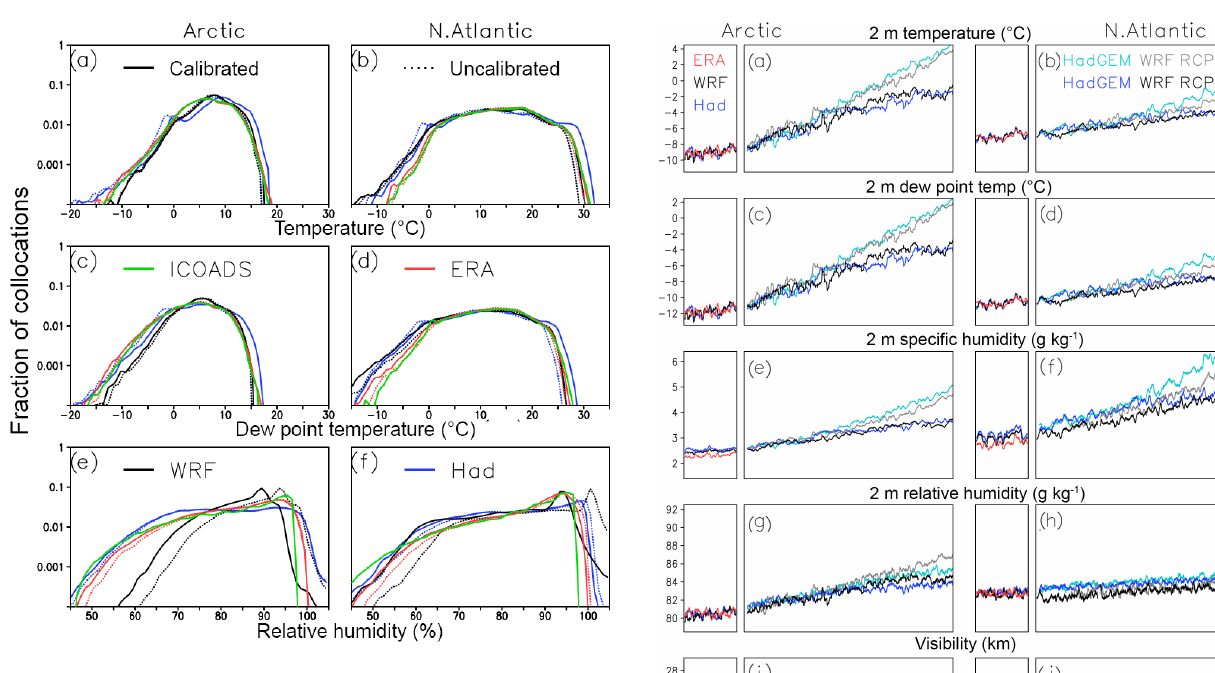
Figure 3. Distribution shifts under a homogeneous two-step cal- ibration. Shown are the fraction of 59966 Arctic (left panels) and 94703 North Atlantic (right panels) collocations of Fig. 1, as a func- tion of calibrated (solid lines) and uncalibrated (dashed lines) (a, b) air temperature, (c, d) dew point temperature, and (e, f) relative humidity with respect to water (at 0.5 ◦ C and 1% intervals, respec- tively, with a three-point smoothing) for the 26-year historical pe- riod. Fractions are shown on a logarithmic scale for the ICOADS observations (green lines), ERA reanalysis (red lines), and WRF (black lines) and HadGEM2 (blue lines) models. Note that WRF boundaries are constrained to the HadGEM2 freely evolving synop- tic evolution, whereas the ICOADS and ERA collocations sample the observed 1979–2004 synoptic evolution.